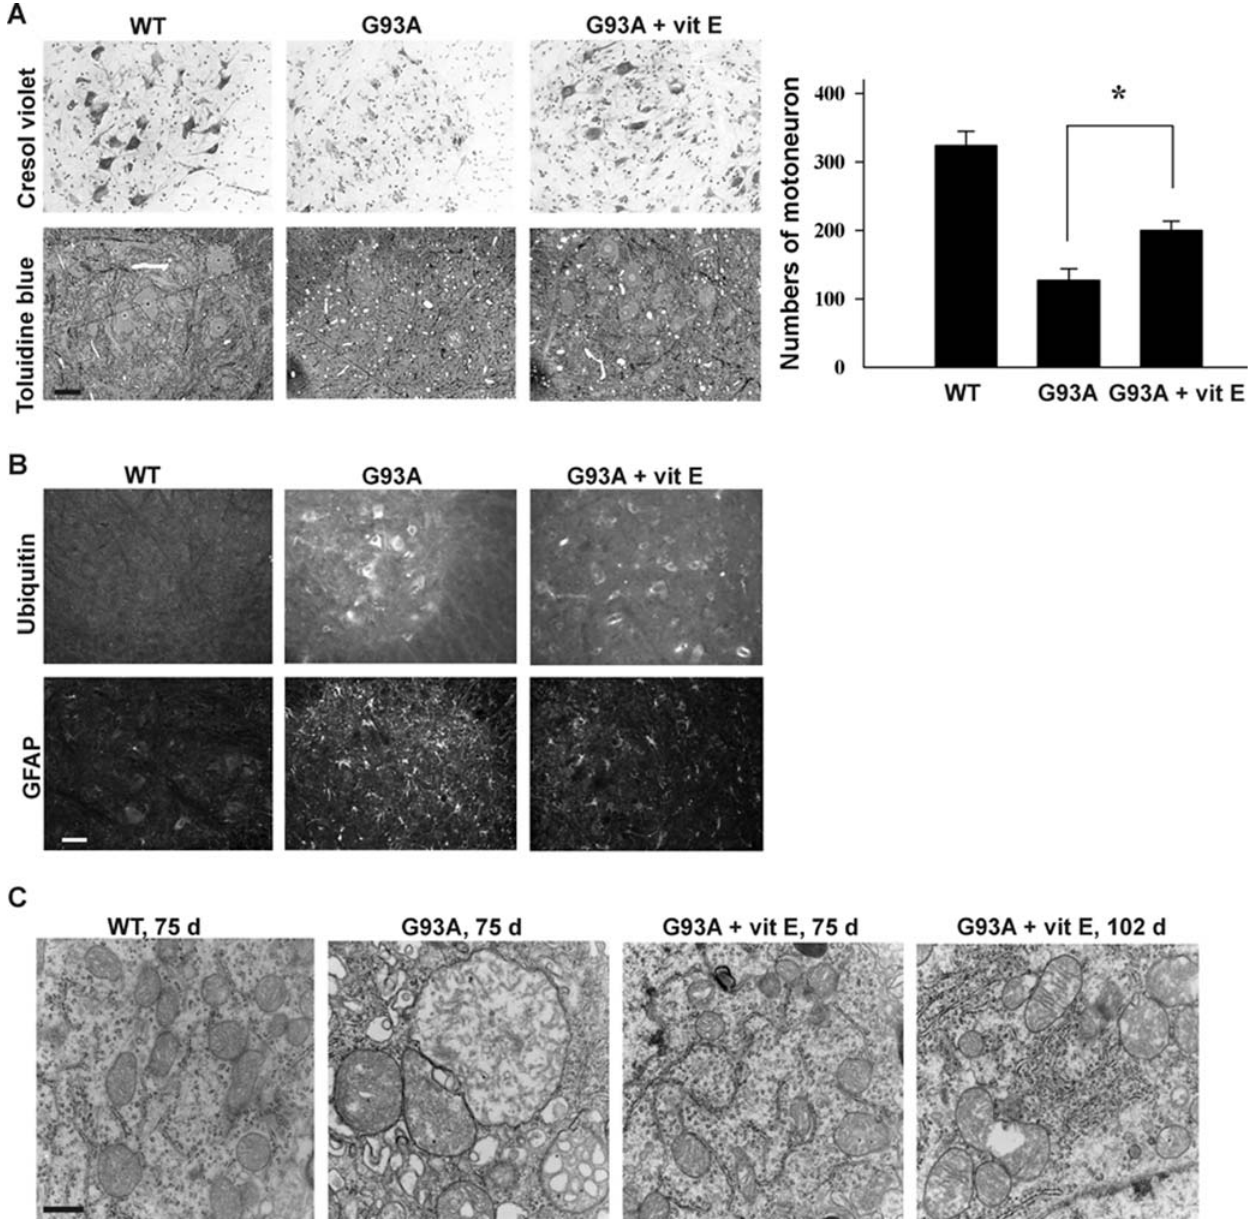
Figure 7. Effect of vitamin E on the course of disease in SOD1G93A mice. ( A ) Cresyl violet-stained and toluidine blue-stained sections through the ventral horn of lumbar spinal cord showed partial preservation of neurons in vitamin E treated mice compared with non-treated mice at age of 100 days. The number of motor neurons in the lumbar spinal cord was counted (n=3 per group, *P , 0.01). Vitamin E delays the progressive loss of motor neurons. ( B ) Immunofluorescent staining of lumbar spinal cord sections showed that gliosis (GFAP staining) and ubiquitin aggregation (ubiquitin staining) were significantly reduced in vitamin E treated mice (100 day-old). The ventral horn area is shown. Scale bar, 10 m m. ( C ) Electron microscopy shows that vitamin E significantly reduces mitochondria vacuolization in motor neurons. Scale bar, 0.5 m